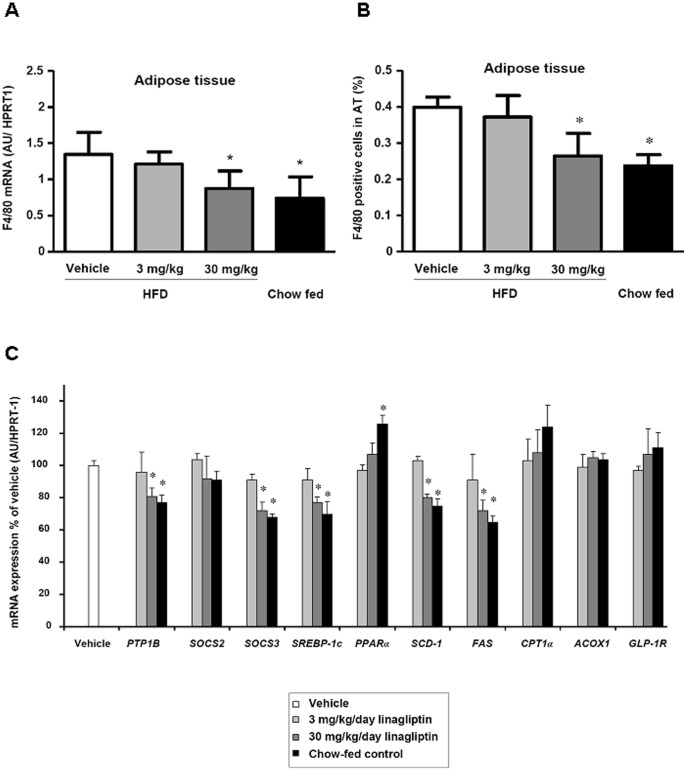
Effects of linagliptin on macrophage infiltration into adipose tissue and on liver mRNA expression of key molecules in liver metabolism and inflammation.(A) mRNA expression of F4/80 and (B) number of F4/80 positive cells in epigonadal adipose tissue of C57BL/6 mice which were fed a high-fat diet (HFD) or chow diet for 3 months followed by treatment with linagliptin (3 mg/kg/day or 30 mg/kg/day) or placebo for 4 weeks. (C) mRNA expression of protein tyrosine phosphatase 1B (PTP1B), suppressor of cytokine signaling 2 (SOCS2), suppressor of cytokine signaling 3 (SOCS3), sterol regulatory element–binding protein-1c (SREBP1c), peroxisome proliferator–activated receptor-α (PPARα), stearoyl-CoA desaturase-1 (SCD-1), fatty acid synthase (FAS), carnitine palmitoyl transferase 1α (CPT1α), acyl-CoA oxidase 1 (ACOX1), and GLP-1 receptor in the liver of C57BL/6 mice which were fed a high-fat diet (HFD) or chow diet for 3 months followed by treatment with linagliptin (3 mg/kg/day or 30 mg/kg/day) or placebo for 4 weeks. mRNA expression was calculated relative to the mRNA expression of hypoxanthine phosphoribosyltransferase 1 (HPRT-1). Data are shown as mean ± SEM. *P<0.05 vs. vehicle.